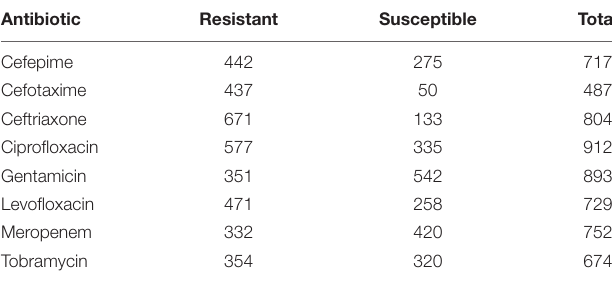
TABLE 1 | Summary of the 915 samples used to build and evaluate antimicrobial resistance prediction models.